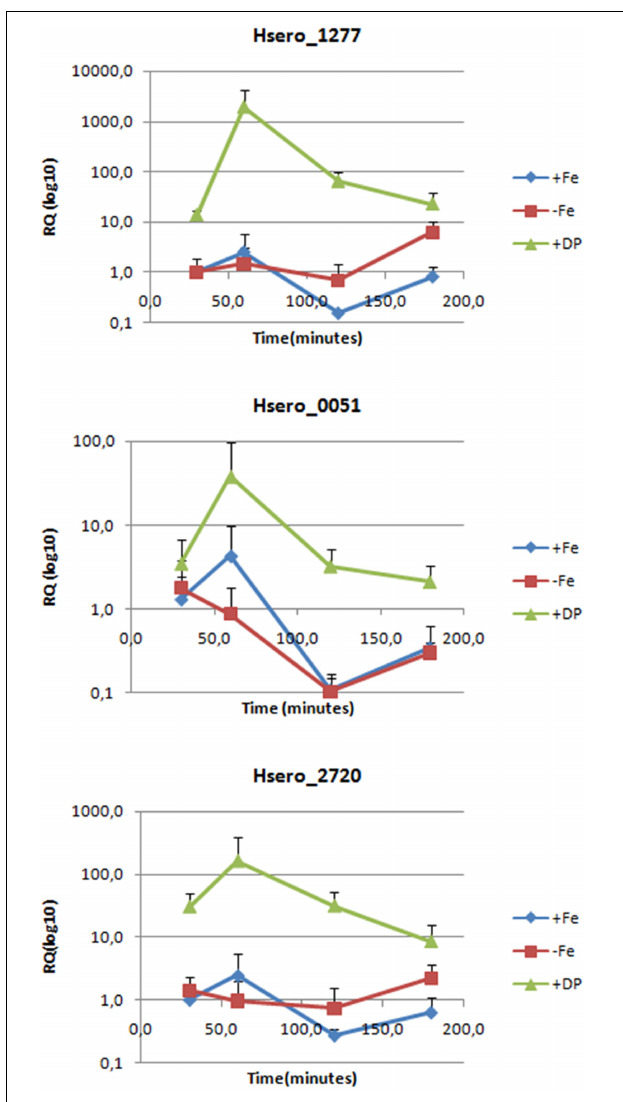
FIGURE 2 | Expression levels of three genes probably involved in iron metabolism measured by RT-PCR. Relative quantification is expressed as base-10 logarithm (RQlog10) for each gene at each assayed time (30, 60, 120, and 180 min), using the 2 - (cid:49)(cid:49) Ct quantifying method; the 16S rDNA as the normalization gene and +Fe 30 min as the calibrator condition. Standard deviation of the three biological replicates is indicated in each